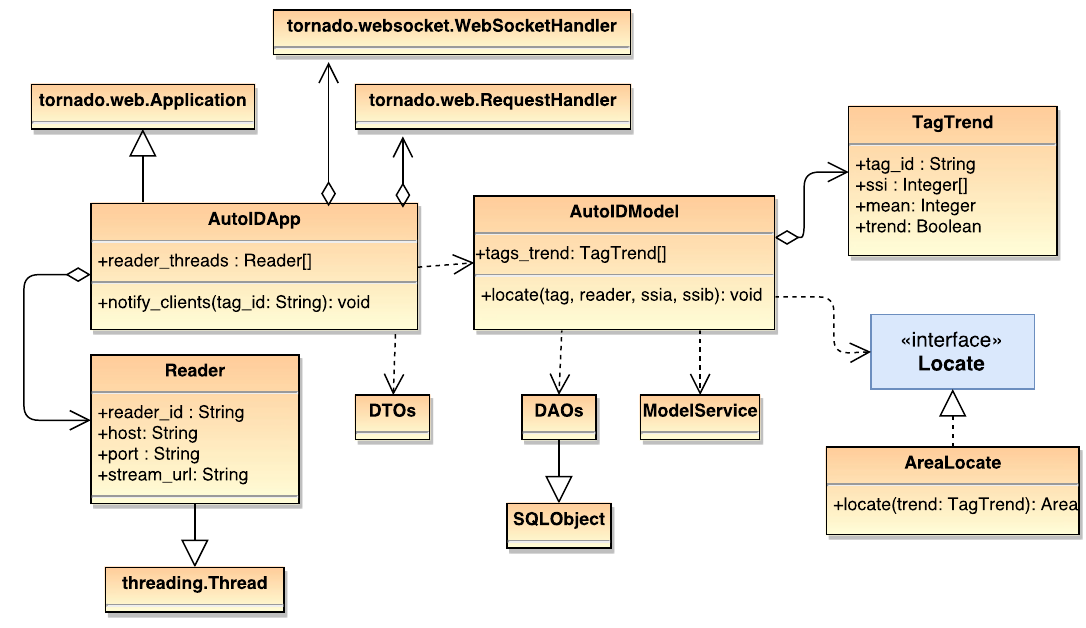
Figure 8. Location class